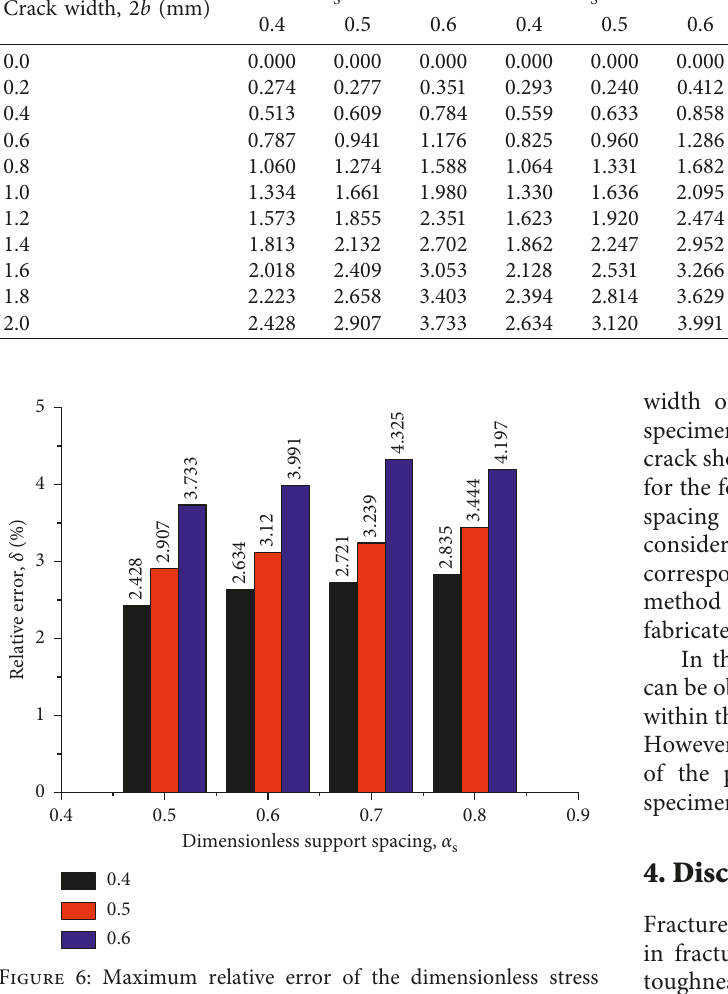
Figure 6: Maximum relative error of the dimensionless stress intensity factor for NSCB